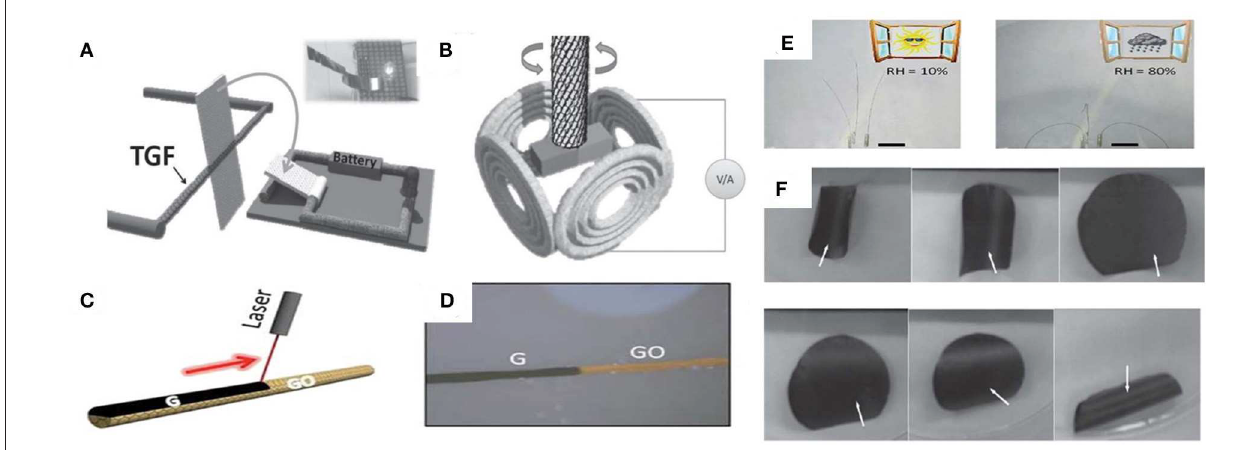
FIGURE 5 | (A) The scheme of the designed humidity switch based on the humidity-responsive the twisted GO fiber in response to moisture (e.g., RH = 85%). (B) The alternating current generator. contains four copper coils around the TGF with a magnet. When the environment humidity changes, TGF can reversibly rotate the magnet within the surrounding copper coils to generate electricity (reprinted with permission from Cheng et al., 2014. Copyright 2014 Wiley-VCH). (C) Left: The scheme of laser positioning reduction on one side of a GO fiber. The black region corresponded to laser induced graphene region along the brown GO fiber. Right: optical image of the top surface for the as-prepared asymmetric G/GO fiber. (D) Photographs of a graphene/GO fiber (2cm in length) under different RH values. (Reprinted with permission from Cheng et al., 2013. Copyright 2013 Wiley-VCH). (E) Photographs of three-wire moisture tentacles of the graphene/GO fibers at the sunny and rainy days, respectively. Scale bars: 5mm. (F) Actuation of the bilayer paper sample as a function of RH. From left to right, RH was 12, 25, 49, 61, 70, and 90%, respectively. White-arrowed side: surface of the graphene oxide layer. (Reprinted with permission from Park et al., 2010. Copyright 2010